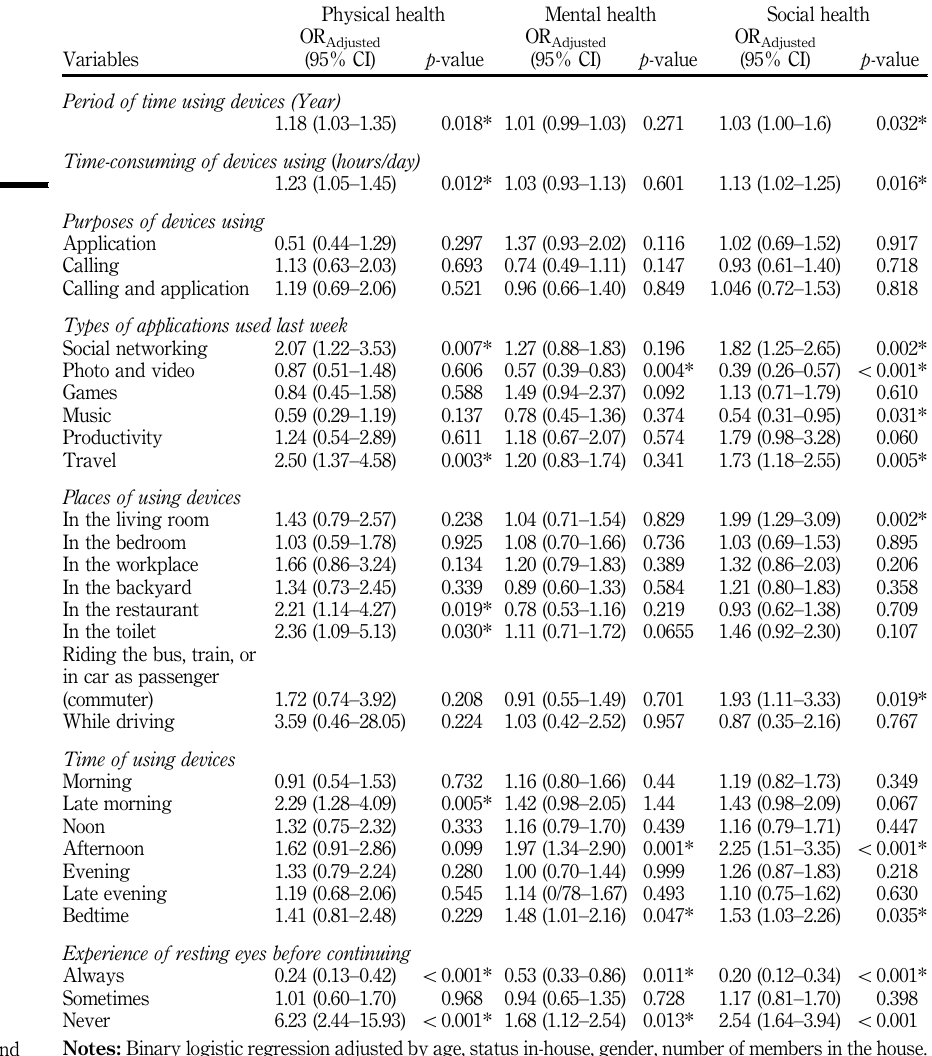
Table II. Association between mobile communications devices usages and health